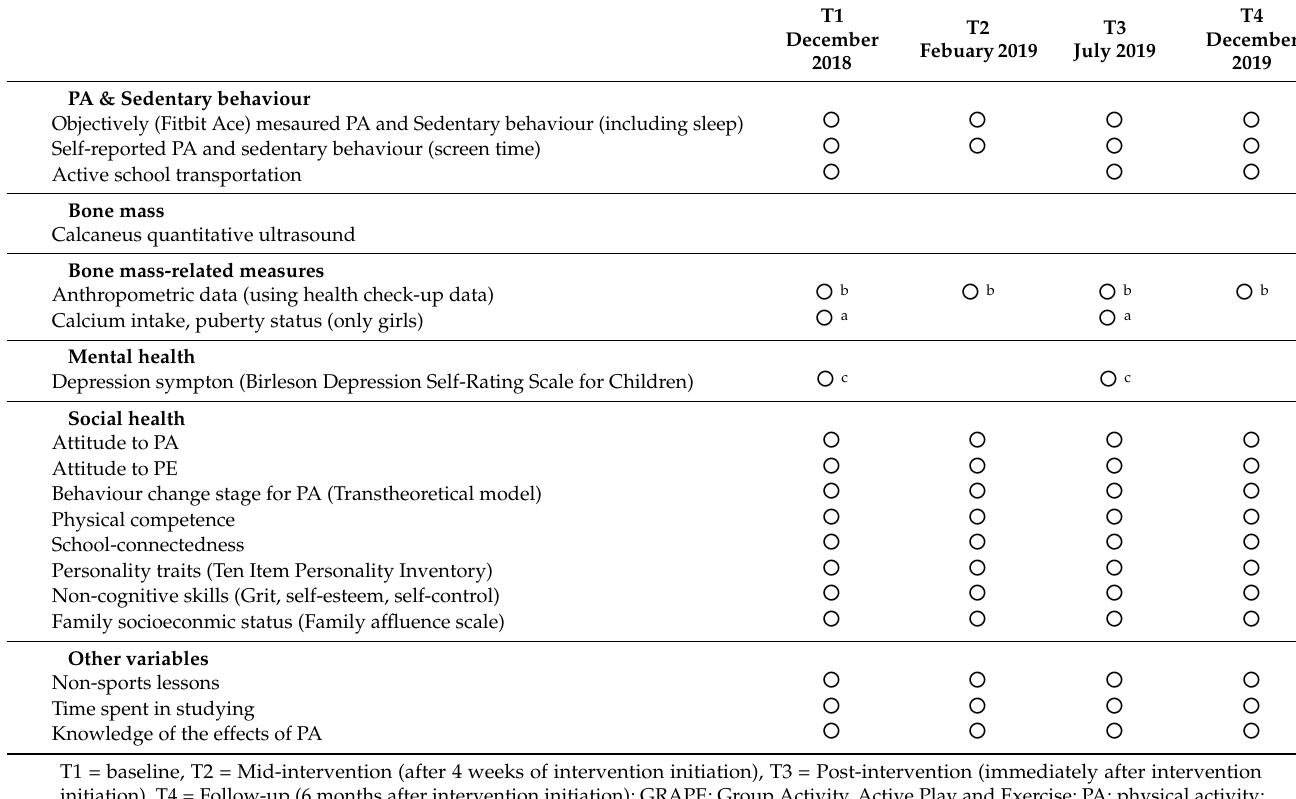
Table 1. Summary of measures among participants in the GRAPE